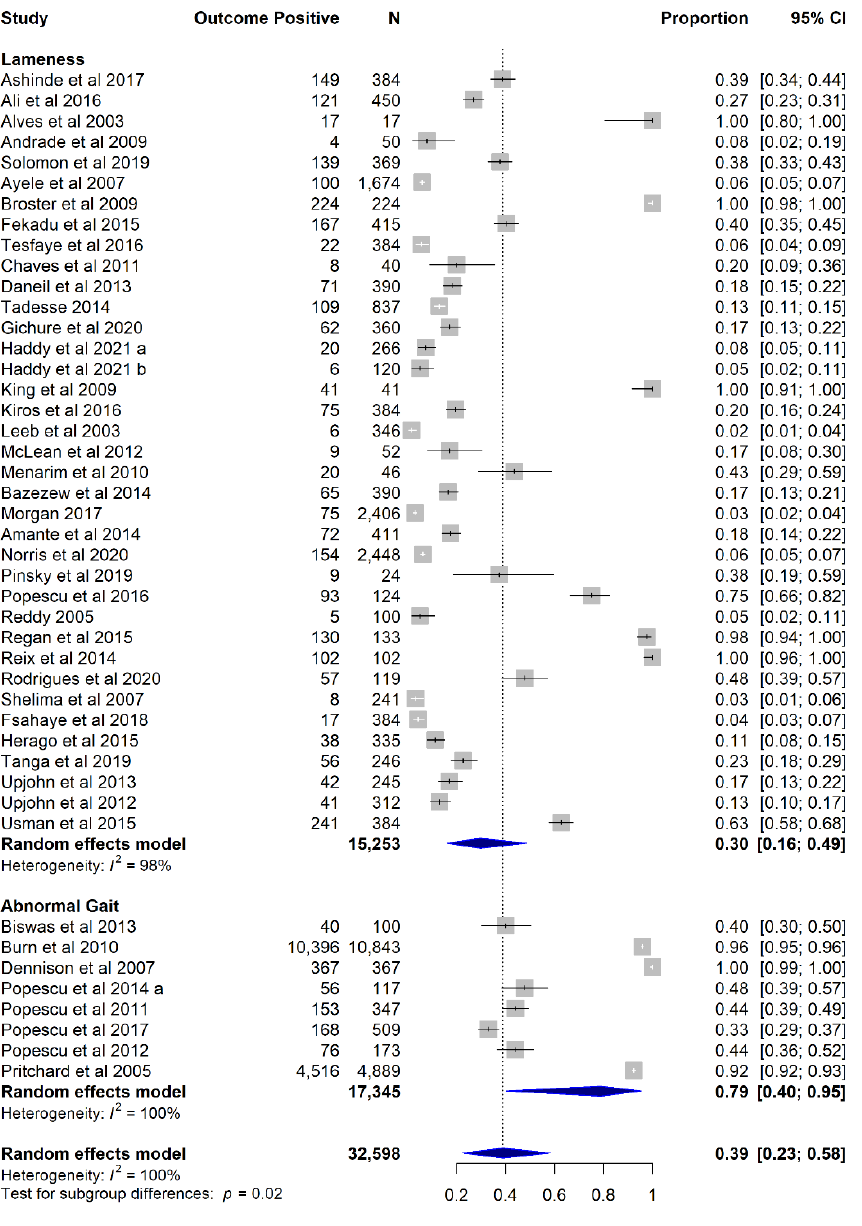
Figure 3. Forest plot illustrating the pooled prevalence of all lameness-related outcomes (lameness and gait abnormality) considered together and as outcome subgroups in a meta-analysis of proportions of studies investigating working equid lameness in low- and middle-income countries, 2003 to 2021: Ashinde et al. 2017 [44], Ali et al. 2016 [14], Alves et al. 2003 [45], Andrade et al. 2009 [46], Solomon et al. 2019 [47], Ayele et al. 2007 [48], Broster et al. 2009 [11], Fekadu et